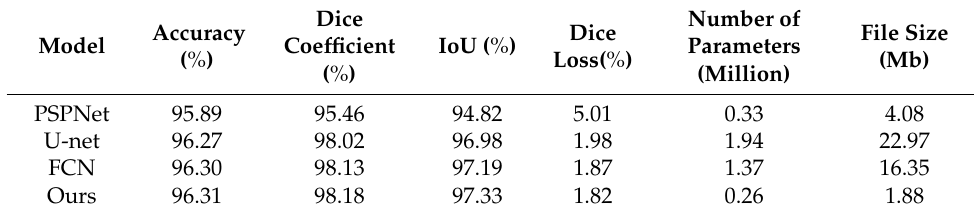
Table 1. Model Performance Comparison with other State-of-the-art models